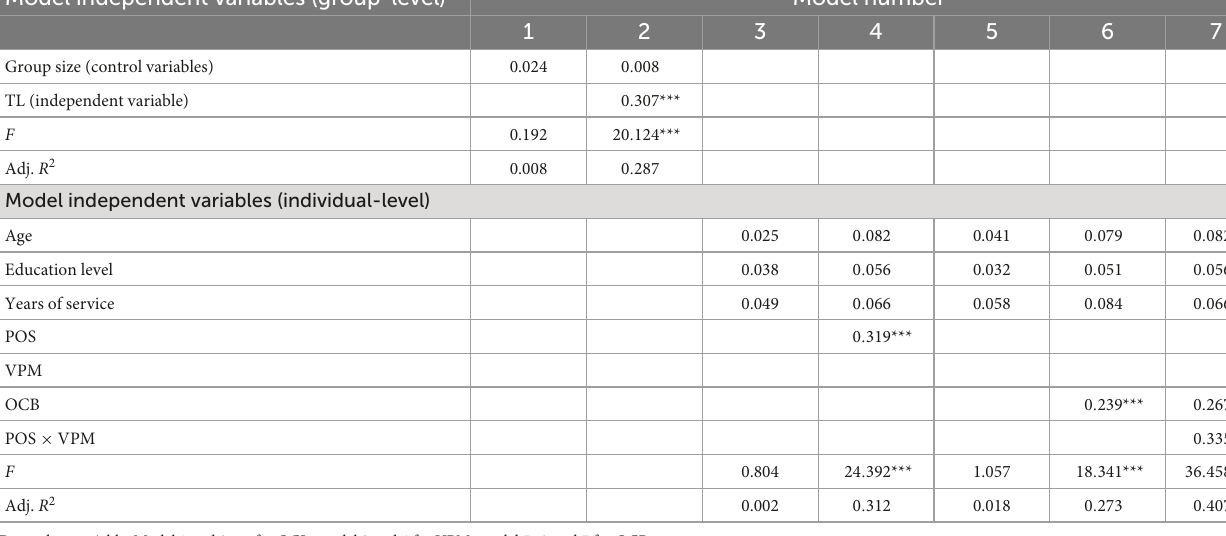
TABLE 3 Hierarchical regression analysis. Model independent variables